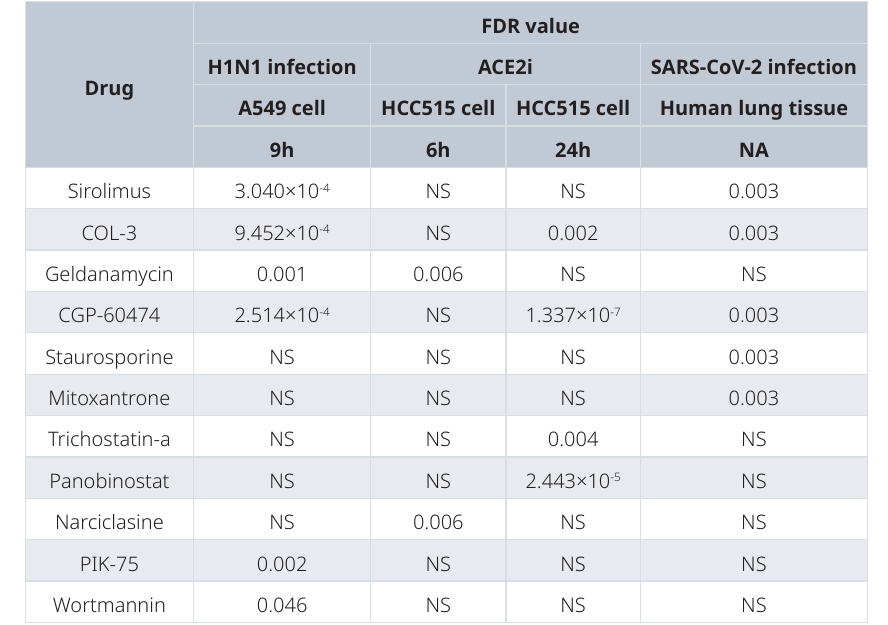
Table 1. Significant candidate drugs for treating infection of H1N1, inhibition of ACE2 and infection of SARS-CoV-2, respectively.